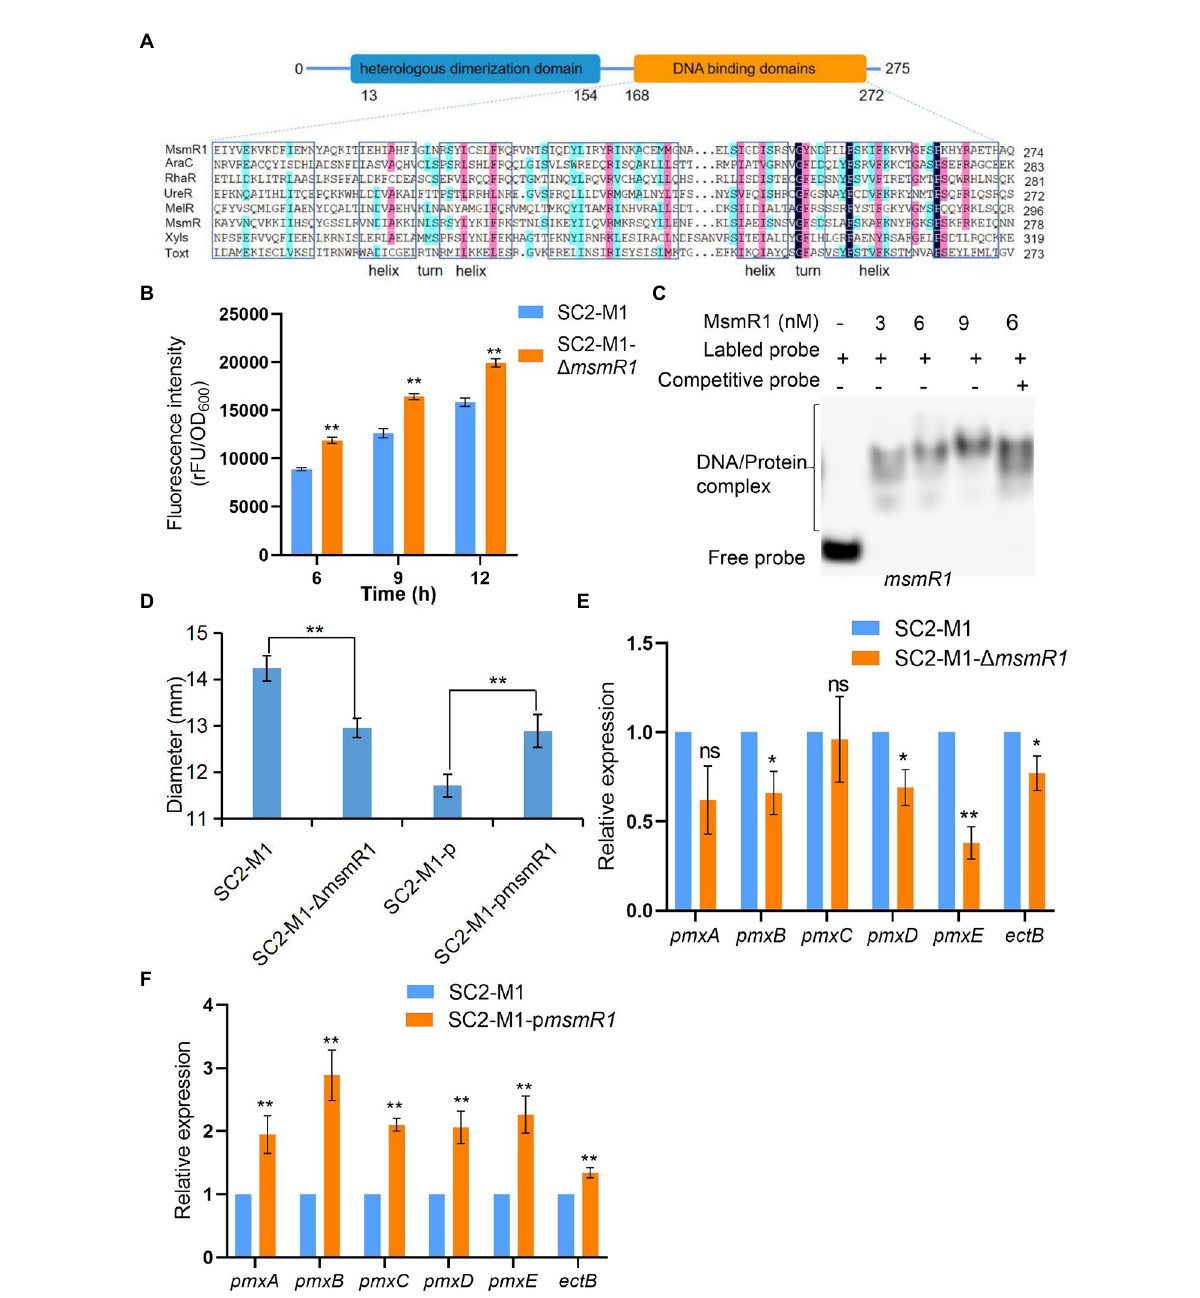
FIGURE 1 Characteristics of MsmR1 protein in Paenibacillus polymyxa SC2-M1. (A) Homologous alignment of MsmR1 protein with several AraC family members: AraC (UniProtKB/Swiss-Prot: P0A9E0), RhaR (UniProtKB/Swiss-Prot: P09378), UreR (UniProtKB/Swiss-Prot: P32326), MelR (UniProtKB/ Swiss-Prot: P0ACH8), MsmR (UniProtKB/Swiss-Prot: Q00753), XylS (UniProtKB/Swiss-Prot: P07859), and Toxt (UniProtKB/Swiss-Prot: A5F384). Sequences were aligned by DNAMAN software. (B) Fluorescence intensity of msmR1 promoter in strains SC2-M1 and SC2-M1- Δ msmR1 detected at different time points. (C) EMSA results depicting MsmR1 binding to its own promoter. (D) Size of the inhibition zone between the SC2-M1, SC2- M1- Δ msmR1 , SC2-M1-p, and SC2-M1-p msmR1 strains was determined using the Oxford cup method. (E) Relative expression of genes related to polymyxin synthesis gene cluster in strain SC2-M1 and SC2-M1- Δ msmR1 . (F) Relative expression of genes related to polymyxin synthesis gene cluster in the control strain SC2-M1-p and the overexpression strain SC2-M1-p msmR1 . * p < 0.05 and ** p < 0.01; ns, p >